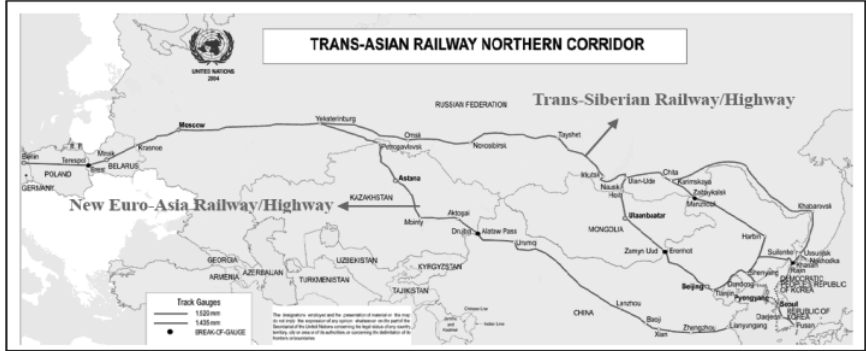
Figure 2. (Trans-Asian railway northern